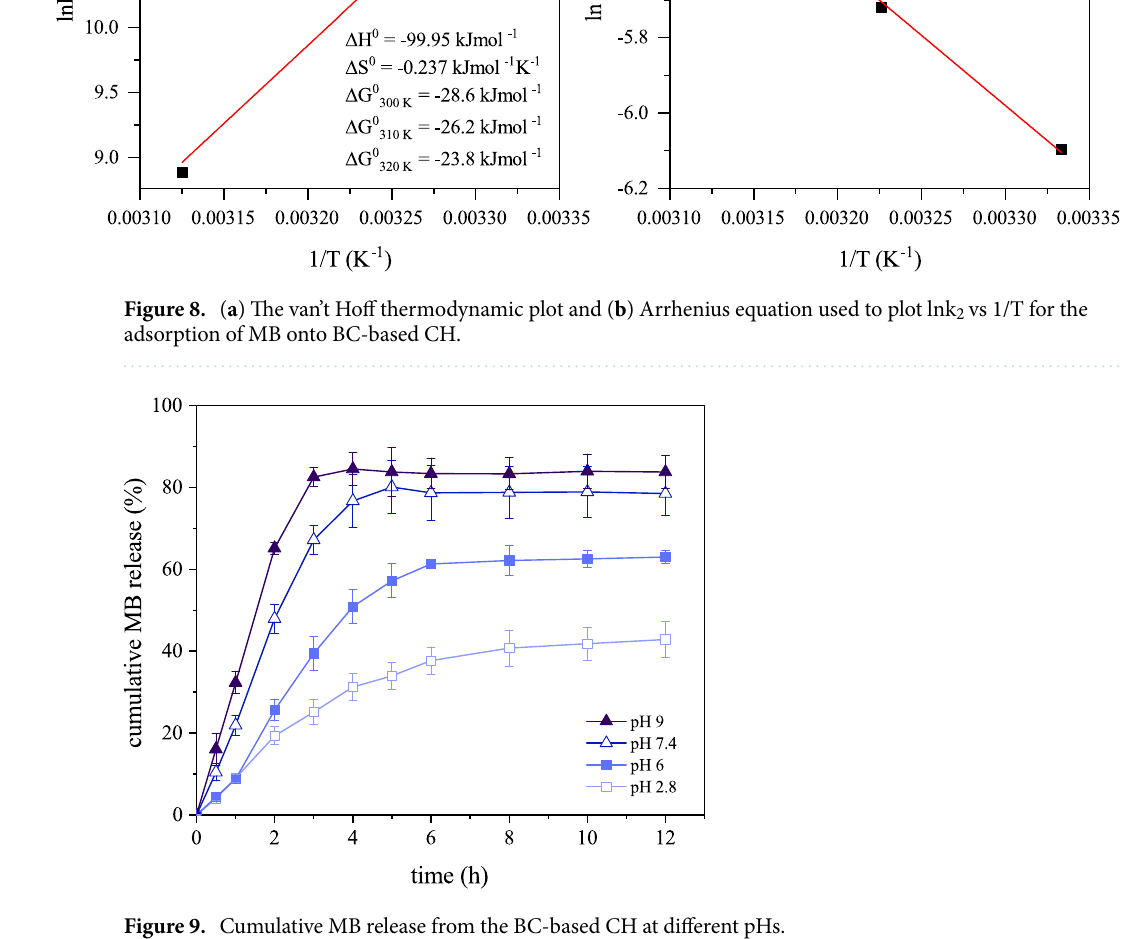
Figure 9. Cumulative MB release from the BC-based CH at different